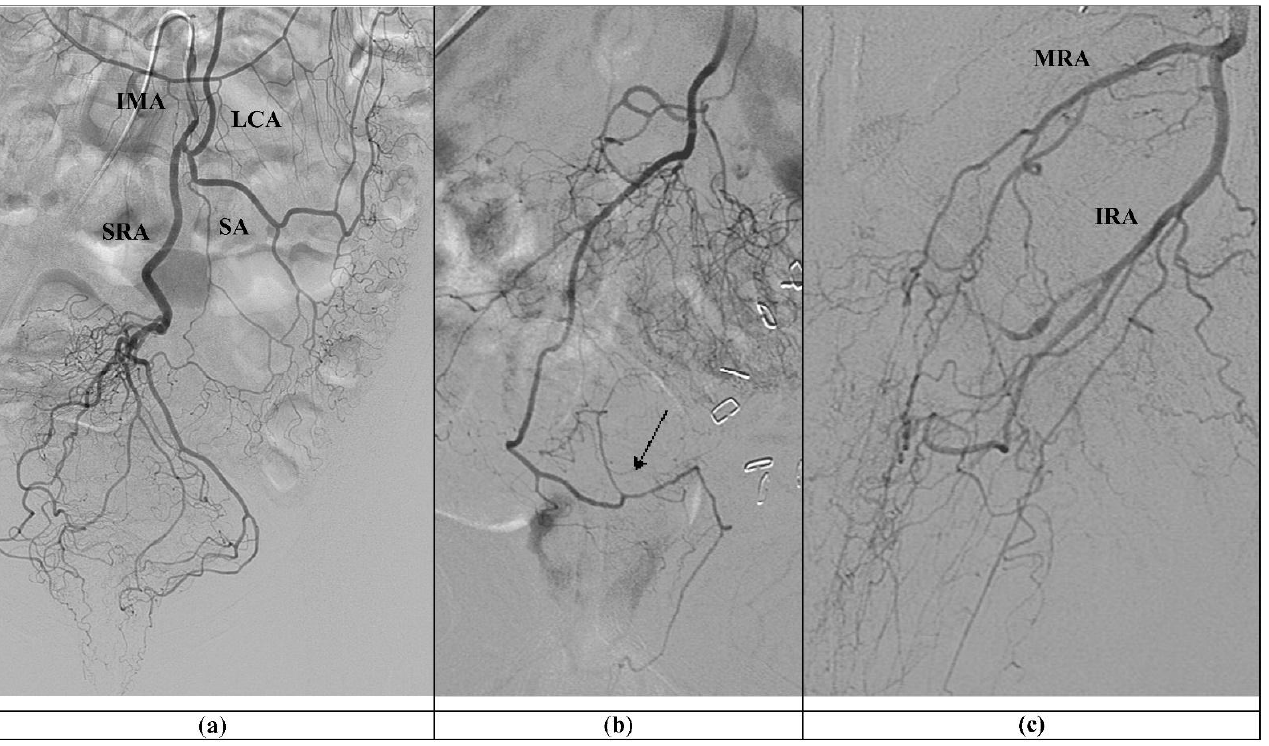
Figure 1. ( a ) Standard vascular anatomy of IMA: left colic artery (LCA), sigmoid arteries (SA), and type I superior rectal artery (SRA) are visualized after contrast injection. ( b ) Type II SRA: a right main trunk crosses and gives branches to the left (arrow). ( c ) Prominent left middle rectal artery (MRA) and inferior rectal artery (IRA) give the main blood supply to the left wall of the distal rec ‐ tum.